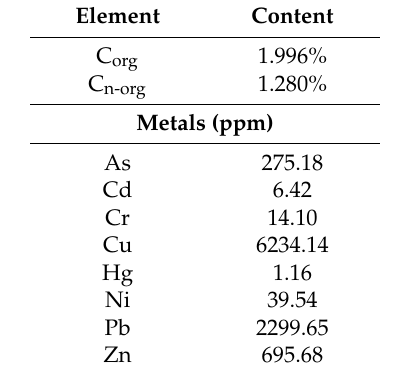
Table 1. The chemical composition of the representative of the copper ore sample used in the research.